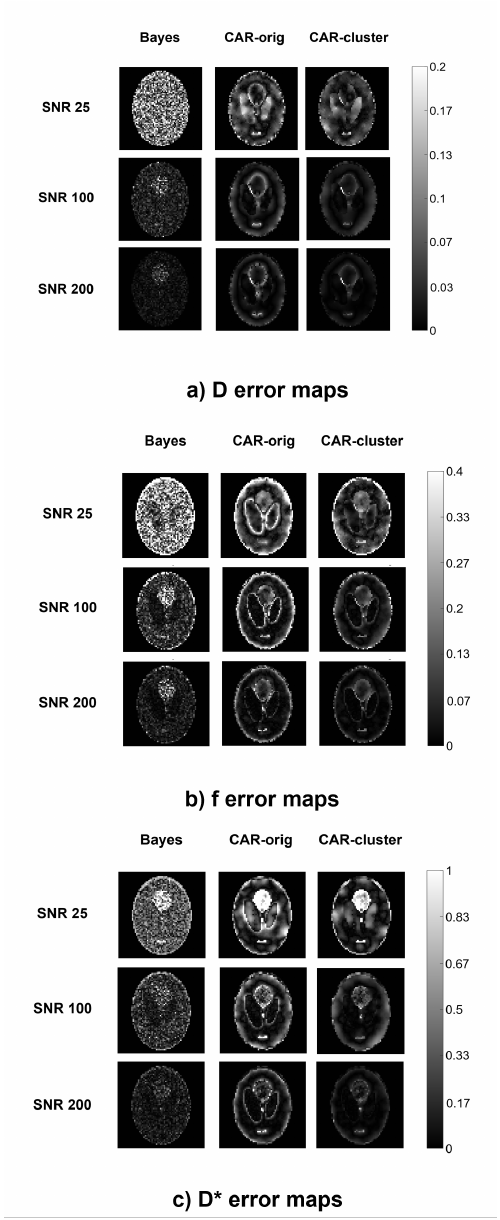
Figure 3. Error ε maps of D ( a ), f ( b ), D ∗ ( c ), computed from a simulated image using the three methods (columns) at different SNR values